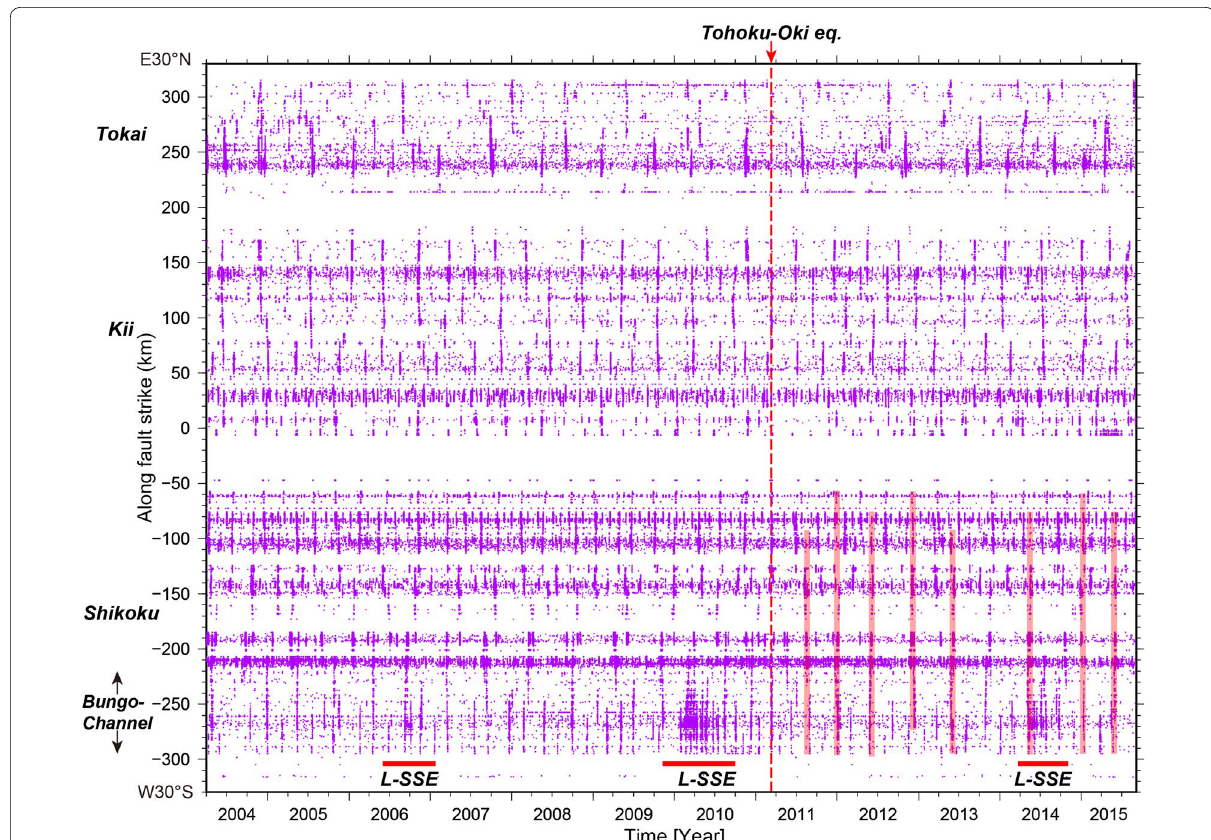
Fig. 2 Space–time diagram of detected LFEs from 1 April 2004 through 31 August 2015. Blue dots denote individual LFEs along a profile aligned E30° N–W30° S, subparallel to the Nankai Trough. Long stripe patterns of LFEs correspond to major ETS episodes. L-SSE means a long-term slow slip event in the Bungo Channel at the western edge of Shikoku island, which has been detected by Takagi et al. (2019). The vertical broken line corresponds to the timing of the 2011 Tohoku-Oki earthquake (Mw 9.0). Red shaded bar denotes an enhancement of rupture connectivity between several segments from Bungo Channel to the eastern